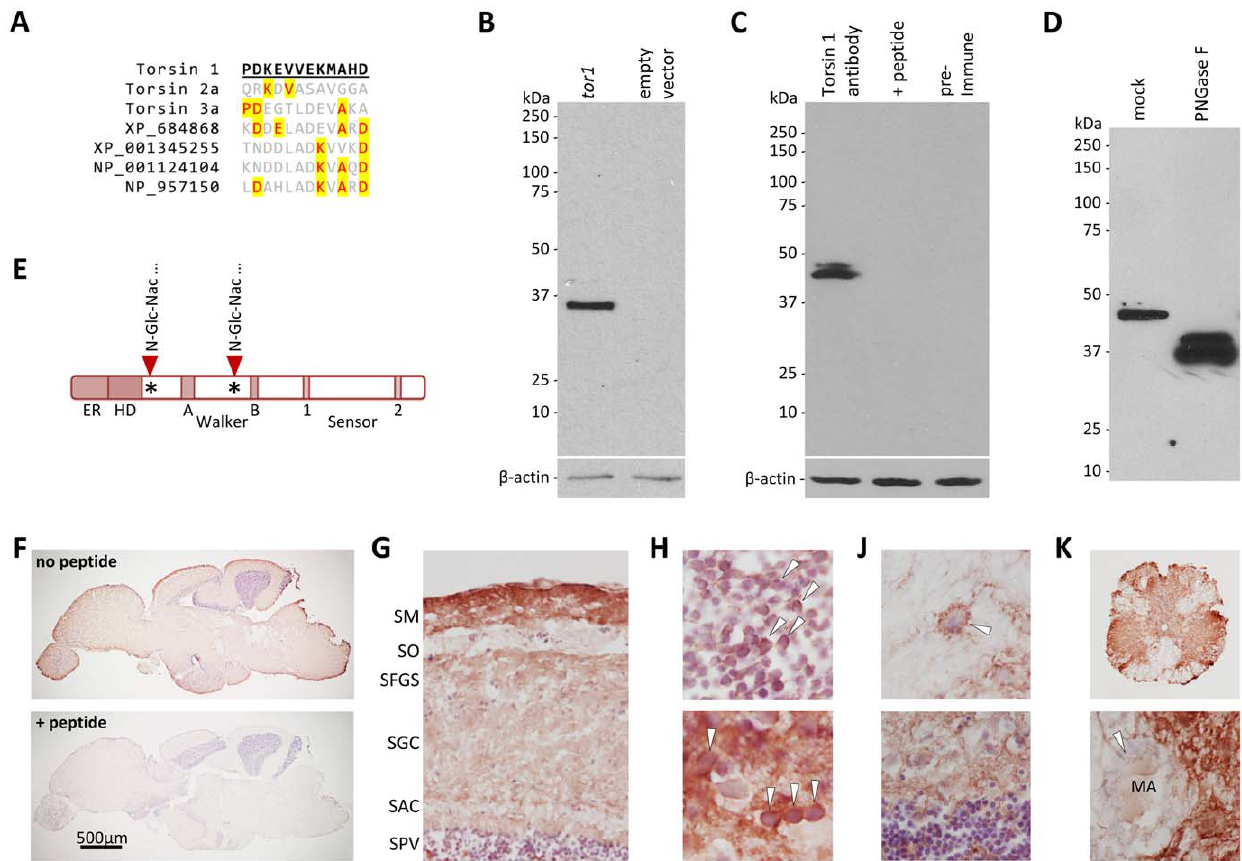
Figure 9. Torsin1 is a neuronal glycoprotein. A: The peptide sequence used to raise polyclonal antibodies to zebrafish Torsin1 is shown underlined in bold. An alignment between Torsin1 and the homologous regions of other zebrafish Torsin-like proteins is shown to illustrate the lack of potentially cross-reacting sequences in other Torsins. Amino acids that are identical to Torsin1 at each position are highlighted in yellow. B: HEK cells were transfected with a plasmid encoding Torsin1b (lane 1) or with empty vector (lane 2). A western blot made with lysates from transfected cells was probed with affinity-purified Torsin1 antibody. The blot was then re-probed with an antibody to b -actin as a control for equal protein loading (lower panel). C: Identical samples of zebrafish whole brain lysate were resolved by SDS-PAGE in adjacent lanes of a gel and the resulting western blot was divided into strips each containing a single lane. The strips were probed with either affinity-purified Torsin1 antibody (lane 1), affinity-purified Torsin1 antibody pre-incubated with the peptide immunogen shown in panel A (lane 2), or pre-immune serum (lane 3). The blots were then re-probed with an antibody to b -actin as a control for equal protein loading (lower panel). D: Whole brain lysate was either treated with PNGase F (lane 2) to remove N-linked carbohydrate moieties, or mock treated without addition of PNGase F (lane 1), prior to SDS-PAGE and immunoblotting with Torsin1 antibody. E: Schematic representation of Torsin1 showing the positions of the consensus N-glycosylation sites. F–K: Adult zebrafish CNS sections were labeled with Torsin1 antibody; immunoreactive structures were revealed by chromogenic histochemistry with a red reaction product. Sections were counterstained with Mayer’s hematoxylin so that nuclei appear blue. (F) Parasagittal sections of the whole zebrafish brain are shown labeled with Torsin1 antibody. In the lower panel, the antibody was pre-incubated with the peptide immunogen. (G) Optic tectum. Key: SM, stratum marginale; SO, stratum opticum; SFGS, stratum fibrosum griseum superficiale; SGC, stratum griseum centrale; SAC, stratum album central; SPV, stratum periventriculare. (H) Periventricular layer of optic tectum (upper panel) and medulla oblongata (lower image), showing cytoplasmic Torsin1 expression in neurons (arrowheads). (J) Thalamus (upper panel) and cerebellum (lower panel) showing Torsin1-related immunoreactivity in neuropil; arrowhead in upper panel shows a neuron surrounded by punctate Torsin1 immunoreactivity that may be present in nerve terminals. (K) Spinal cord at low magnification (upper panel) and high magnification (lower panel) showing robust Torsin1 immunoreactive signal in gray matter, but absence of Torsin1 in white matter. The arrowhead in the lower panel shows the myelin sheath surrounding the